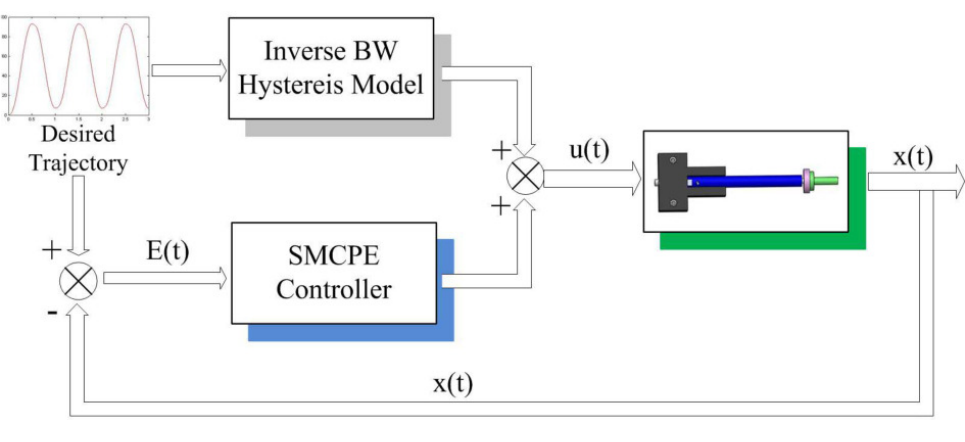
Figure 6. Schematic diagram of the tracking control system for piezoelectric actuators (PEAs).